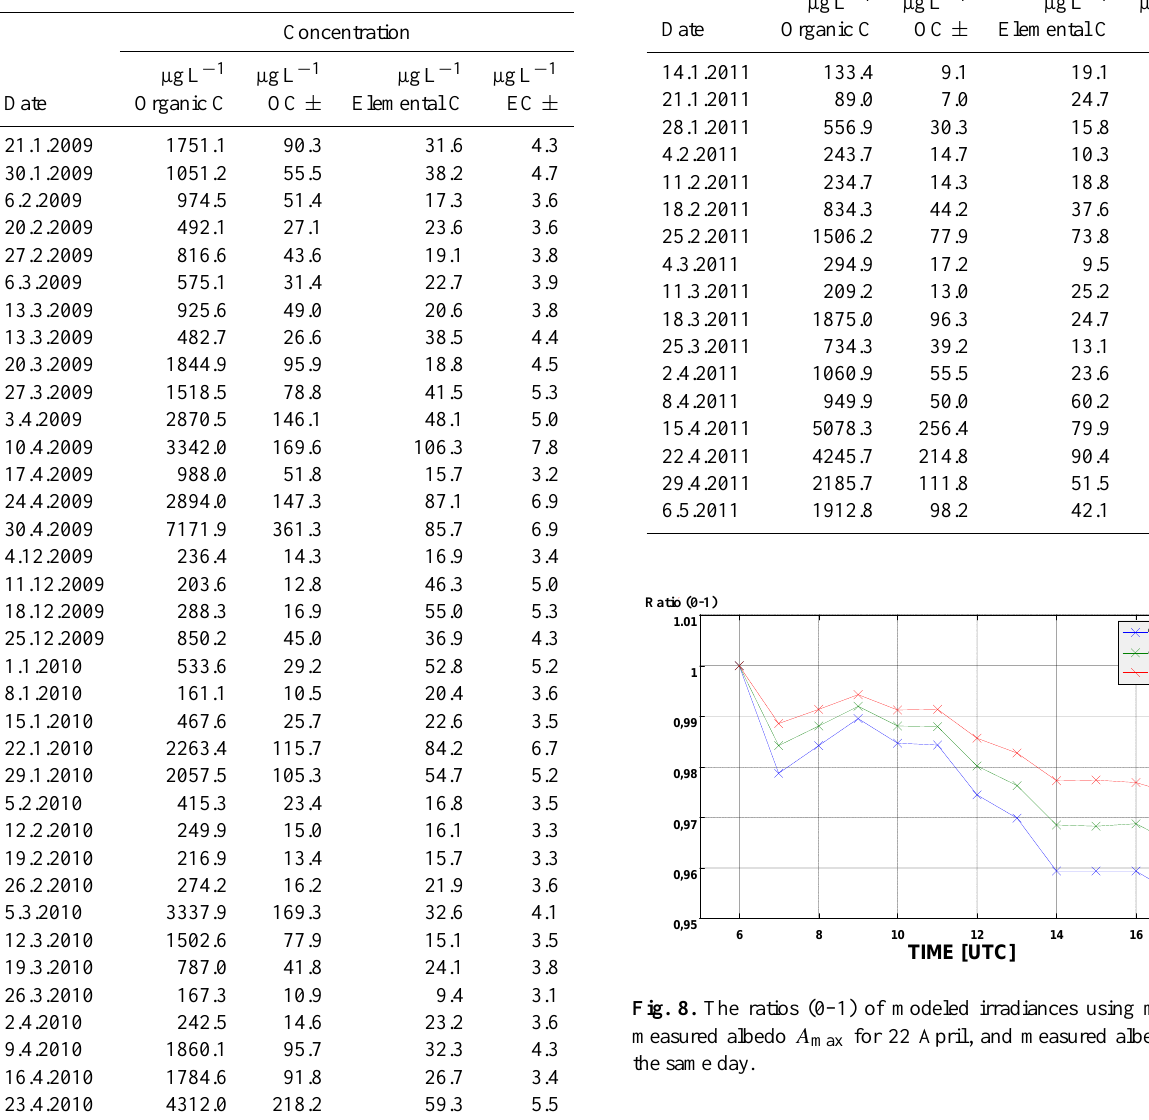
Table 3. Results of EC and OC [ppb] in the snow samples of the So- dankyl¨a Arctic Research Center, since the beginning of 2009 until the snowmelt in spring 2011.